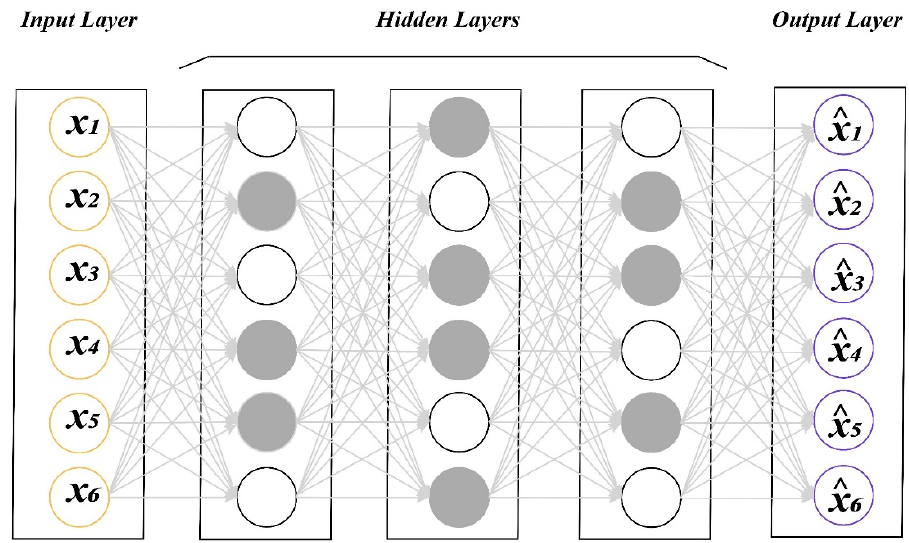
Figure A3. Graphical representation of an SAE model with three hidden layers. Note: Gray-colored circles are neurons deactivated using the regularization term.